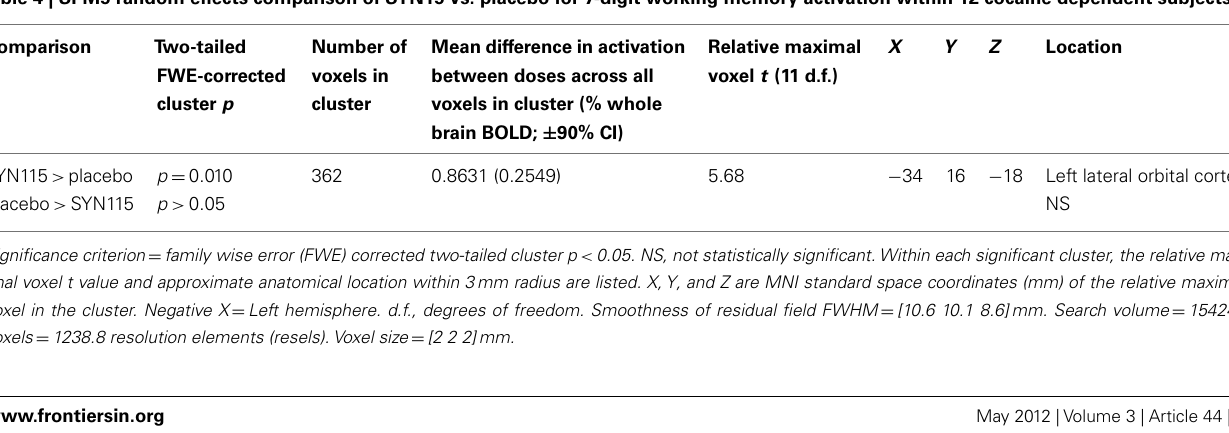
Table 4 | SPM5 random effects comparison of SYN15 vs. placebo for 7-digit working memory activation within 12 cocaine dependent